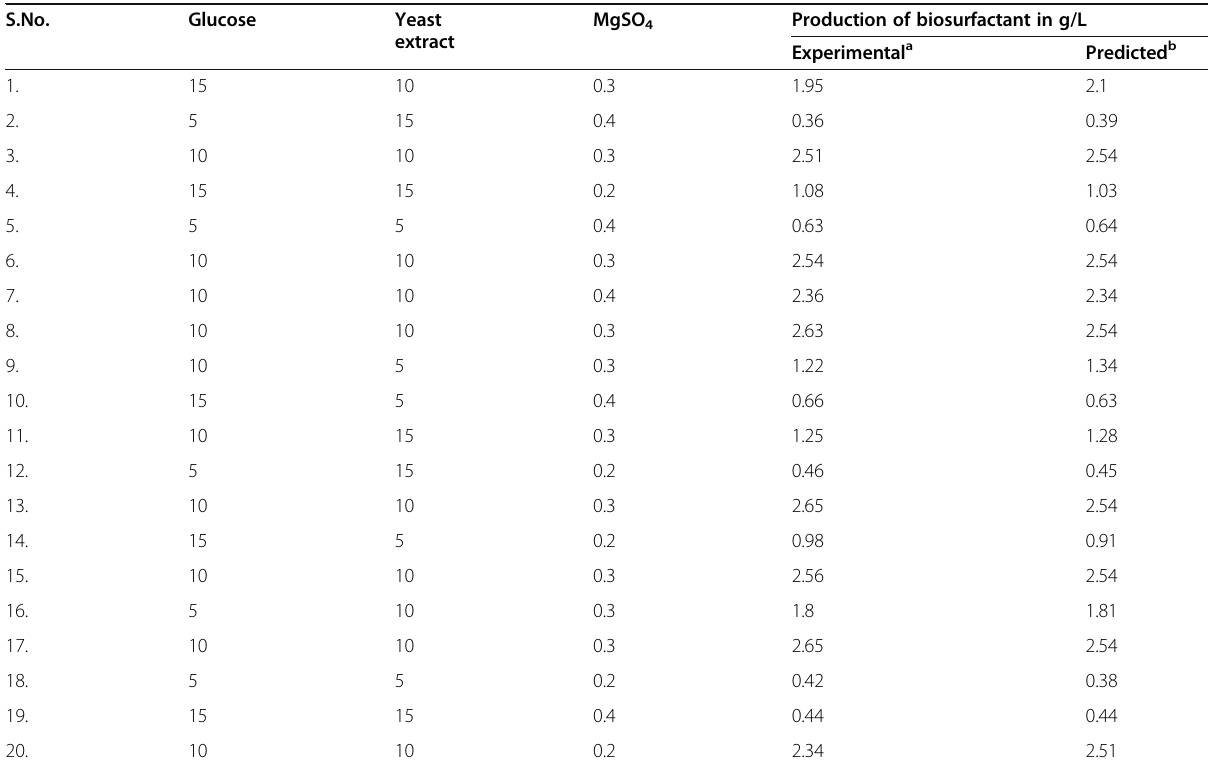
Table 5 Actual data for design of experiments